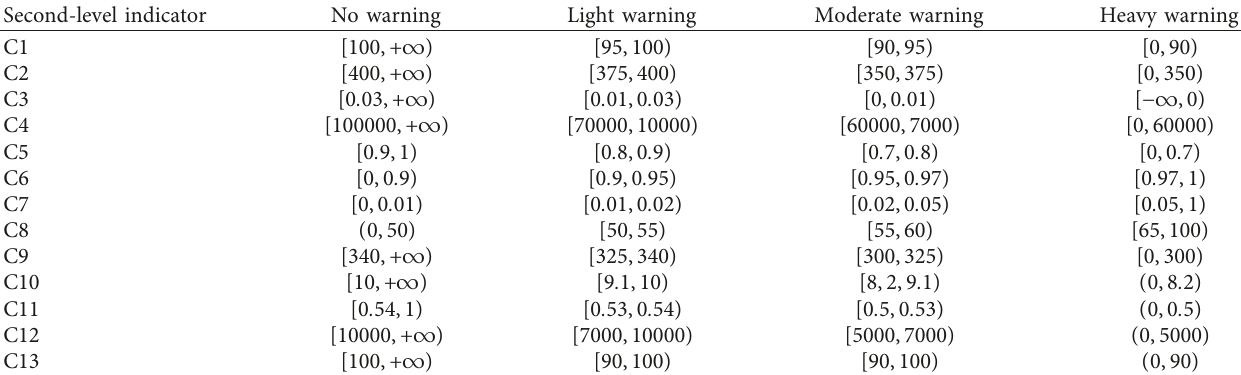
Table 7: Construction of food security early warning indicator